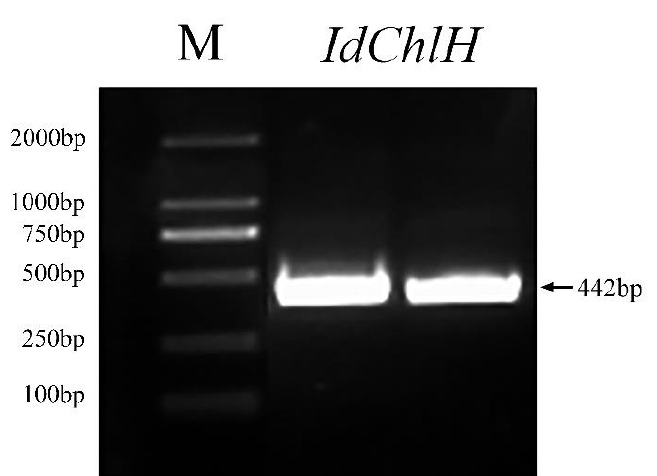
Figure 3. Cloning of IdChlH gene specific fragment in I. dabieshanensis . M: 2000 DNA marker.